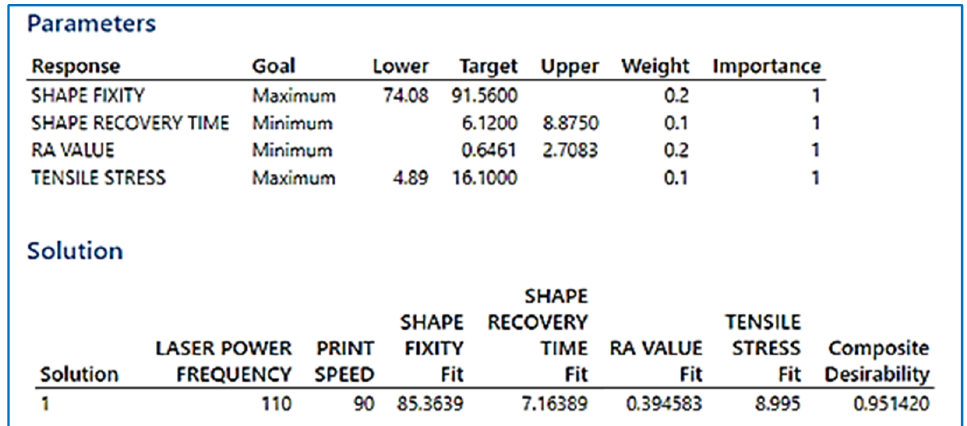
Figure 9. Response Optimization for tBA-co-DEGDA samples printed on various print parameters.